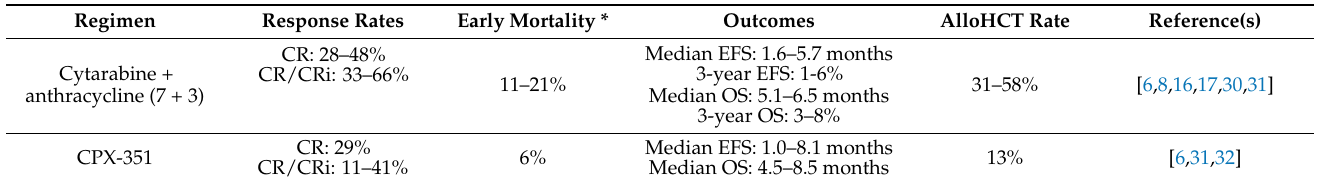
Table 1. Summary of experience with intensive therapy for TP53 -mutated acute myeloid leukemia. Regimen Response Rates Early Mortality * Outcomes AlloHCT Rate Reference(s) Cytarabine + anthracycline (7 +